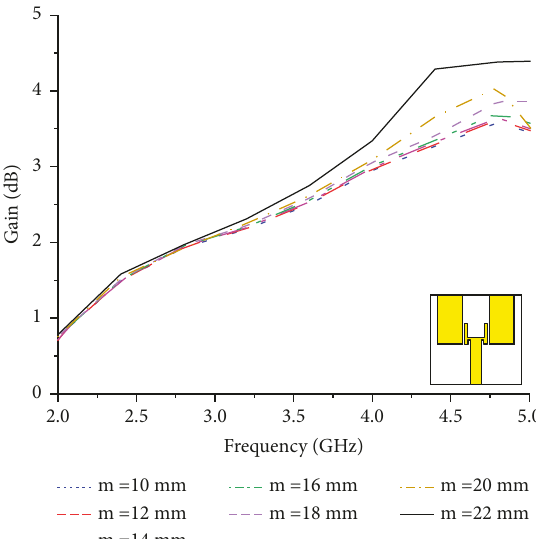
Figure 7: Variation of the gain for different length of parasitic element on patch ( m ).